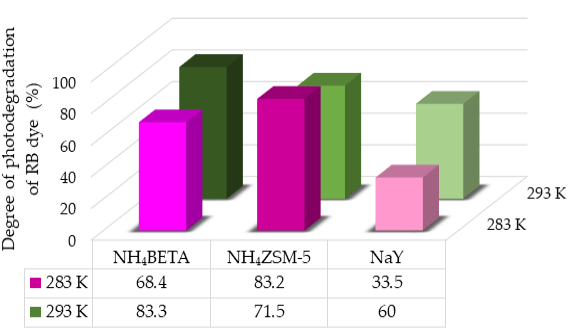
Figure 9. Degree of photodegradation of RB dye in the presence of selected zeolites under the UV radiation at two temperatures after 180 min.